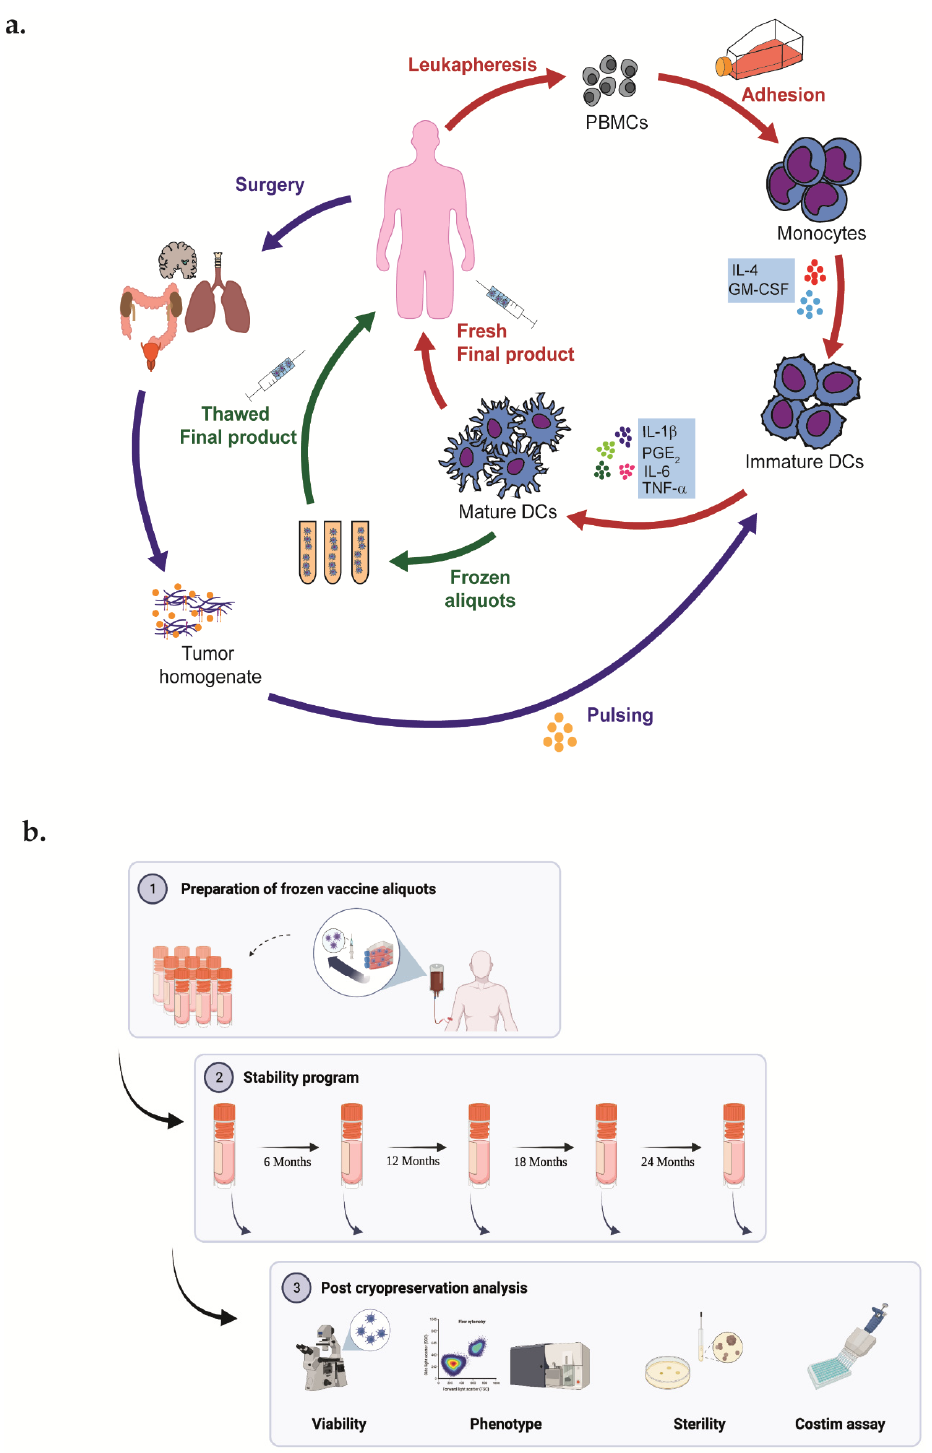
Figure 1. ( a ) Representative graphical of DCs vaccine manufacturing. Patients’ monocytes are obtained by leukapheresis procedure and subsequently differentiated into DCs. Cells are cultured with GM-CSF and IL-4; on day 6, DCs are pulsed with autologous tumor homogenate derived from surgically removed tumor; and on day 7 are matured for 48 h with TNFa, IL-1b, IL-6, and PGE2. Finally, a fresh final product is administered to the patient. ( b ) Representative graphical abstract of experimental plan of stability program created with